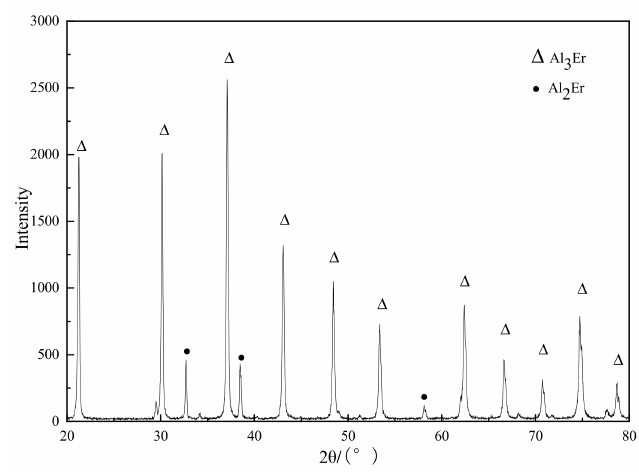
Figure 13. XRD pattern of Al 3 Er alloy (Al 3 Er PDF#17-0666, Al 2 Er PDF#17-0667).